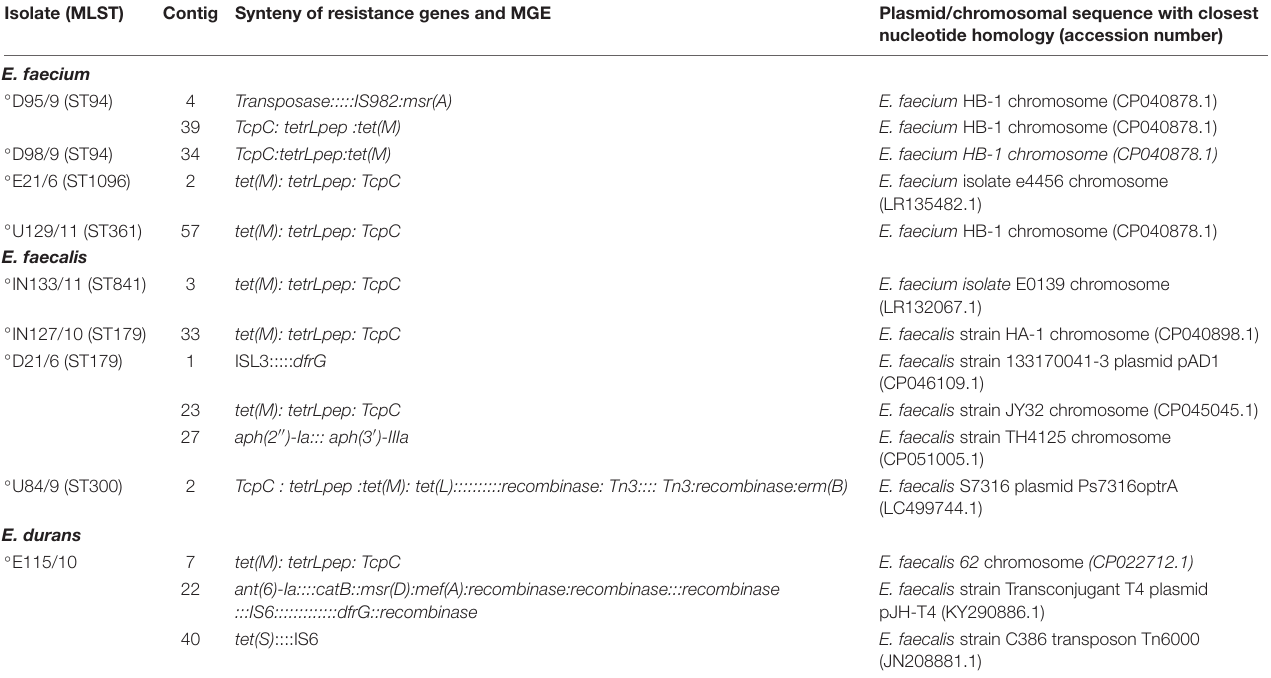
TABLE 3 | Mobile genetic elements associated with antibiotic resistance genes in Enterococcus spp. Isolate (MLST) Contig Synteny of resistance genes and MGE Plasmid/chromosomal sequence with closest